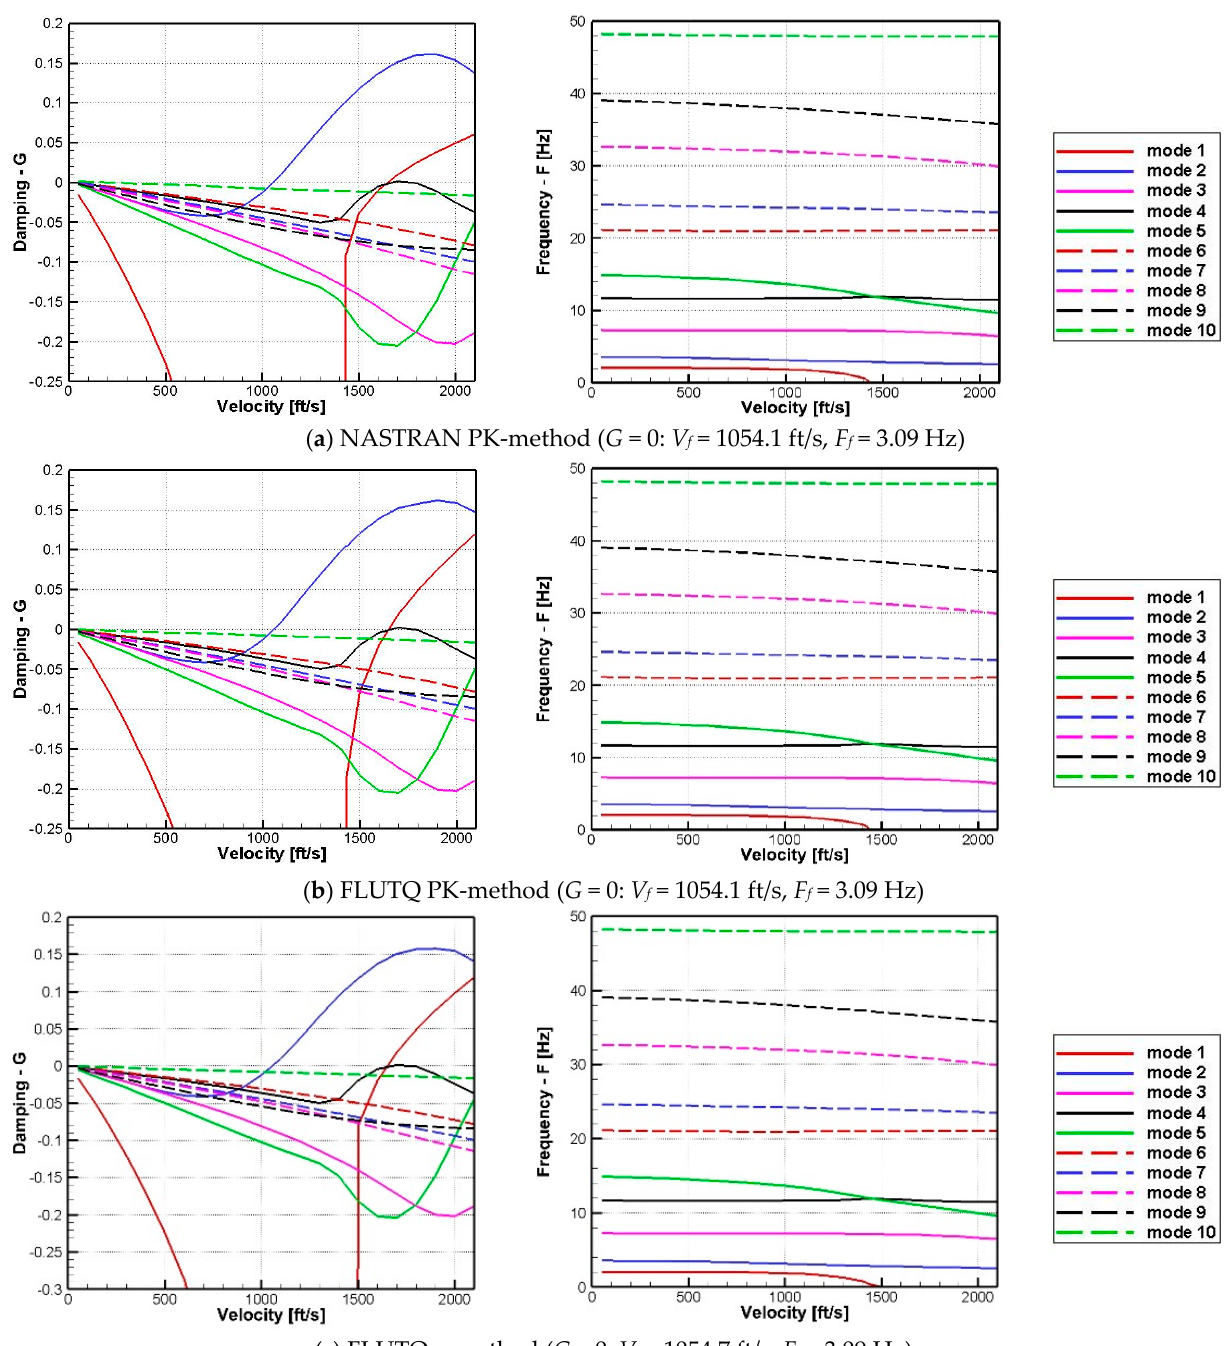
Figure 5. Damping ( left ) and frequency ( right ) diagrams for the BAH wing. The aerodynamics of the aircraft were modelled using the DLM. The one-side single wing consisted of 140 panels. The fuselage was modelled by five elliptical-section slender body elements and five cylindrical interference elements. The empennage and underwing stores were not modelled aerodynamically. The tip-mounted store was modelled as an open-ended octagonal cylinder with 184 panels. The flutter analyses assumed the following: